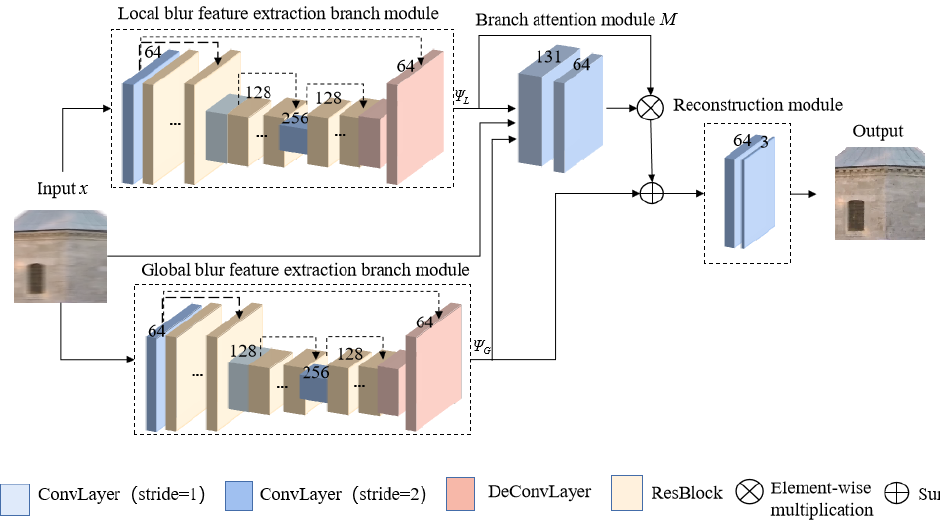
Figure 2. Dual-branch decoupling network